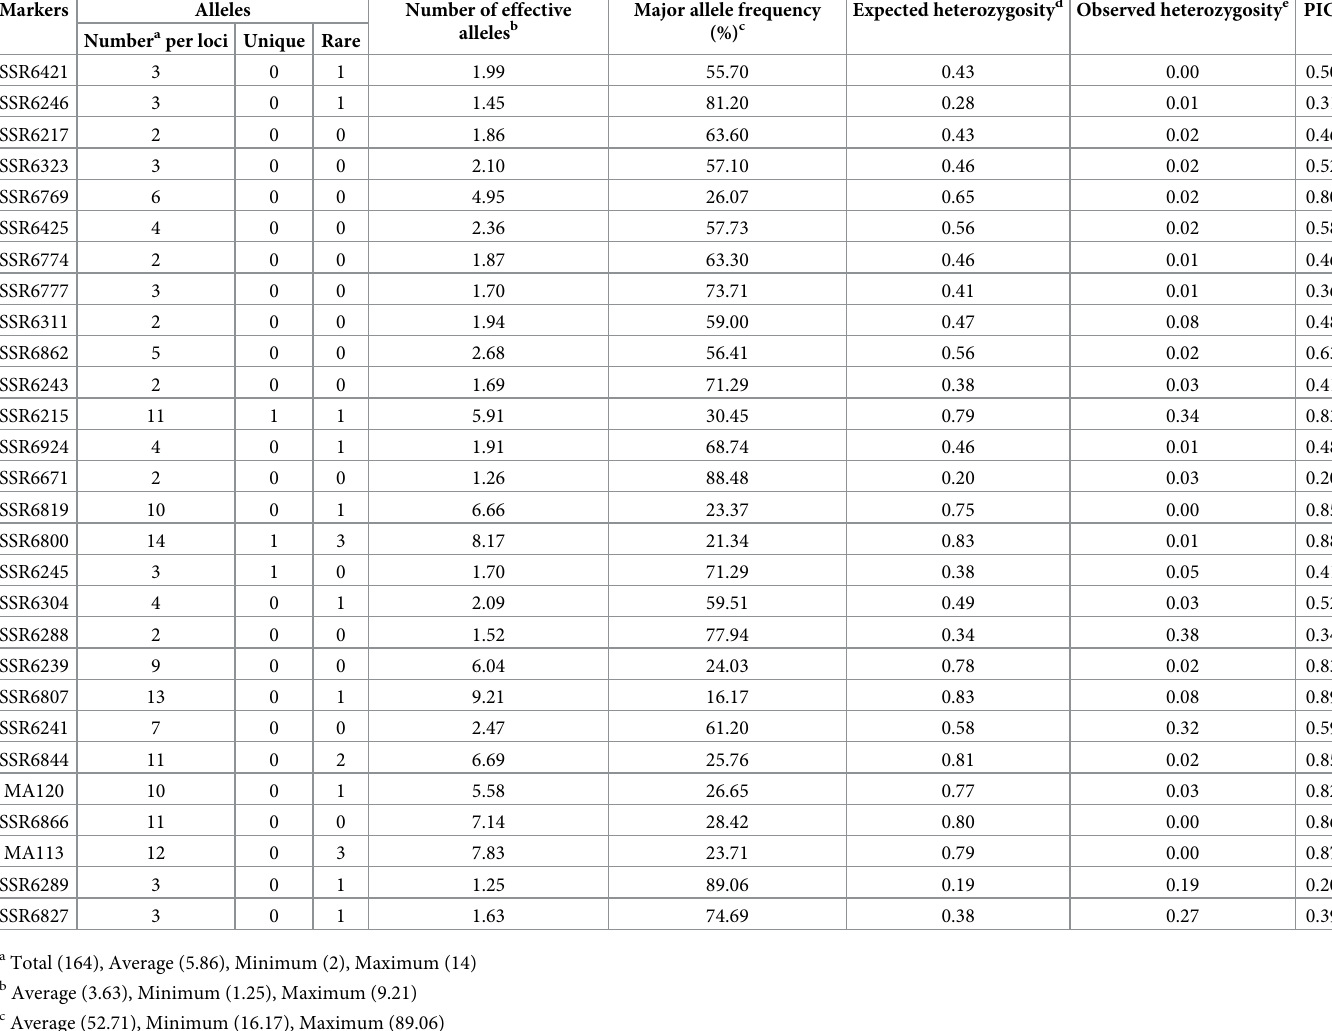
Table 3. The number of alleles per locus, major allele frequency, expected heterozygosity, observed heterozygosity and polymorphism information content (PIC) of the 28 SSR markers across 70 cowpea accessions. Markers Alleles Number of effective